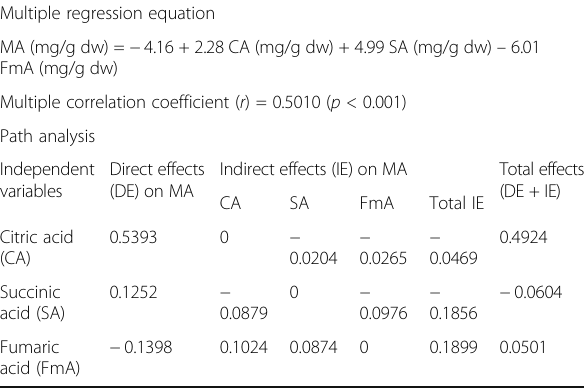
Table 3 Multiple regression and path analyses of organic acids of TCA